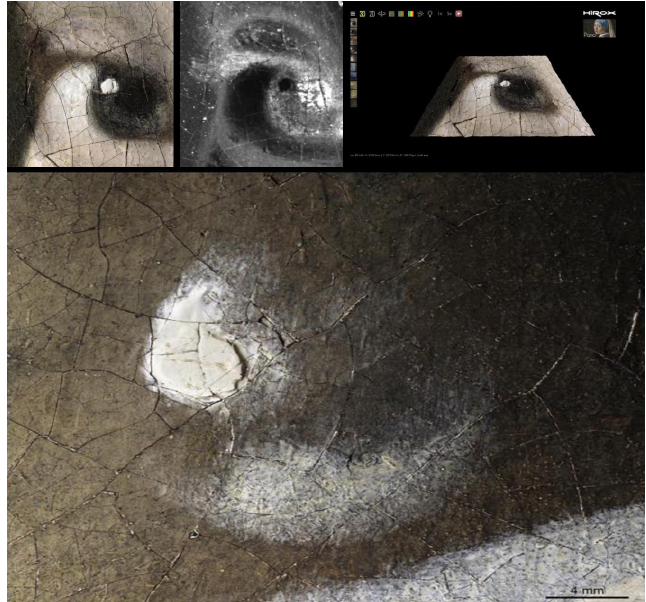
Fig. 2 M. Lo Turco,